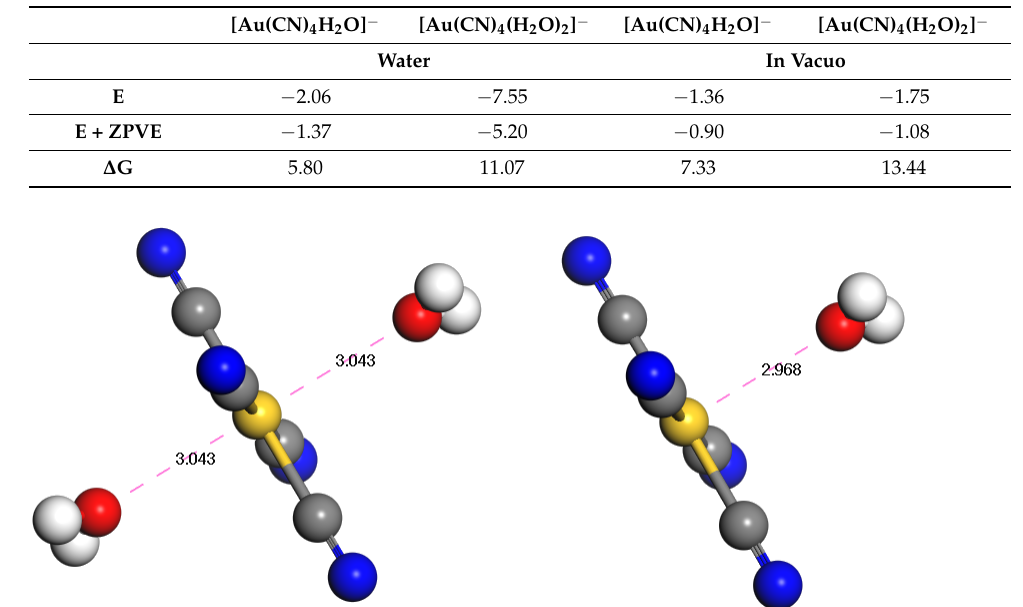
Table 7. Energy (E); energy corrected by the zero-point vibrational energy (E + ZPVE); Gibbs free energy ( ∆ G) of the complex formation of gold(III) tetracyanide aquo and diaquo complexes. In vacuo—results obtained without solvation. Water—results obtained using PCM implicit solvation model. All values are in kcal/mol.